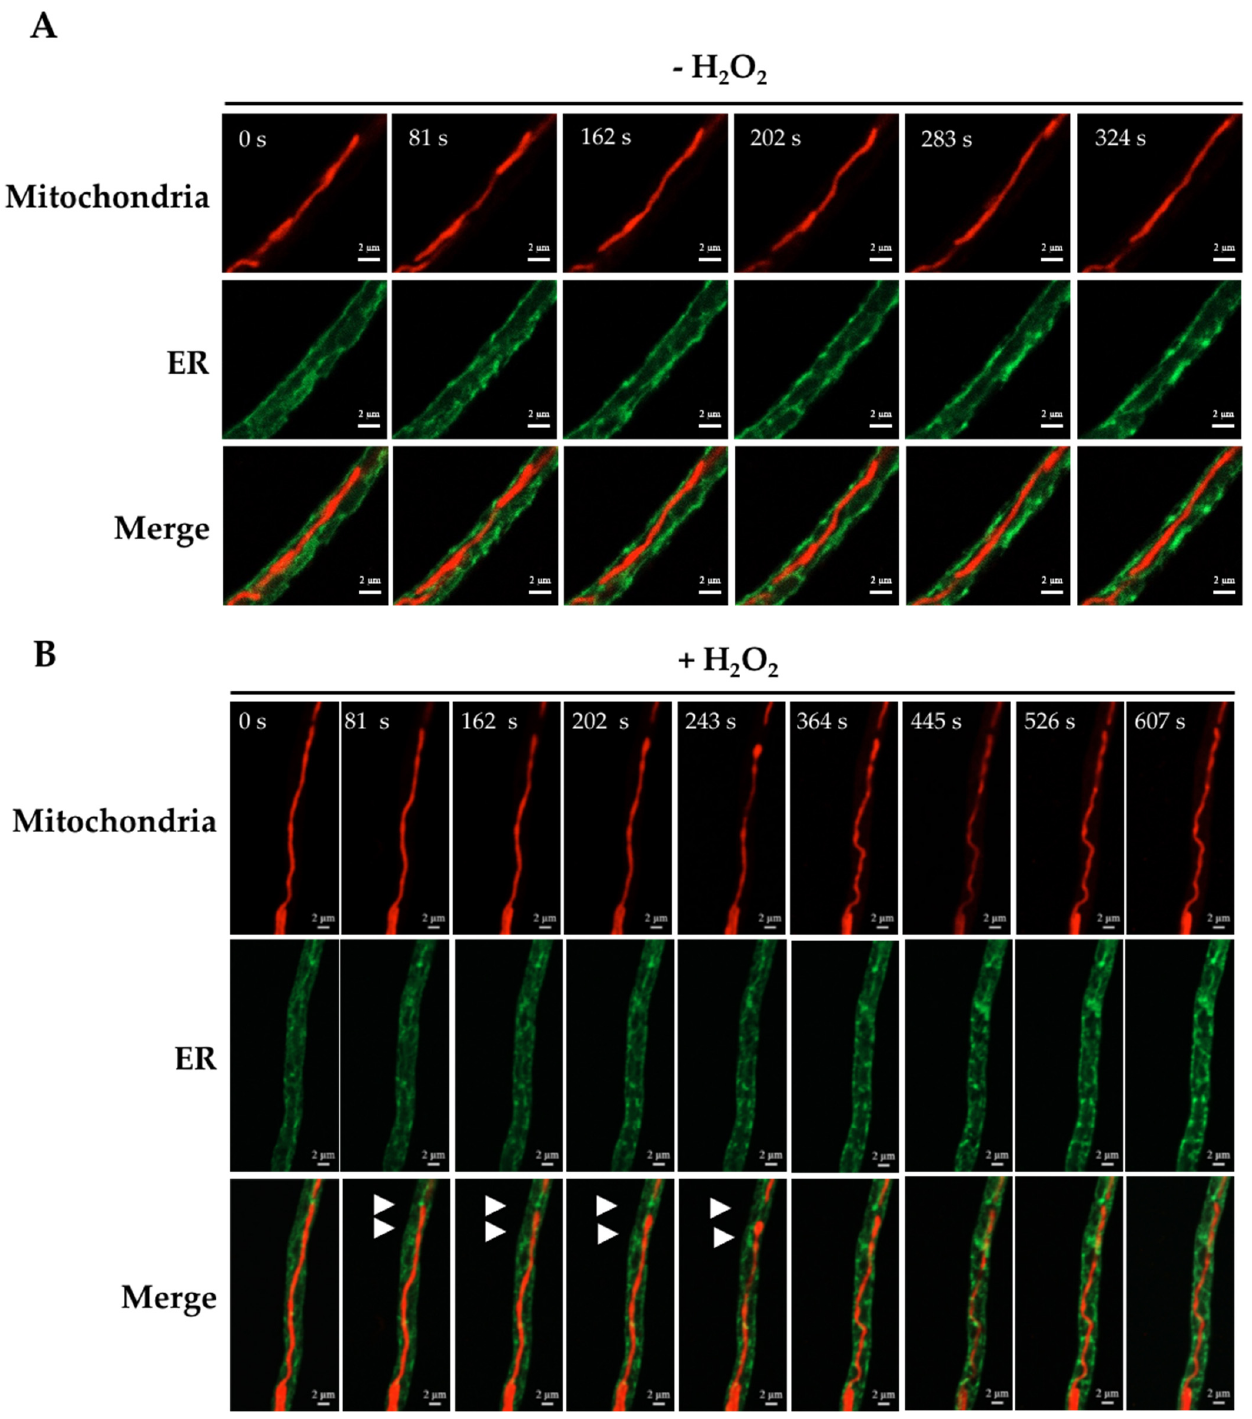
Figure 10. Mitochondria–ER contacts are essential in order to produce mitochondrial constrictions in response to H 2 O 2 . Mycelia from a slow-growing section from Δ mdmB heterokaryon HGV2, grown on selective media for 5 days, was treated ( B ) or not ( A ) with 5 mM H 2 O 2 for 30 min, and was then observed for the indicated times using confocal microscopy. The white arrowheads in ( B ) point to a ER–mitochondria contact point where an incipient mitochondrial constriction is observed.